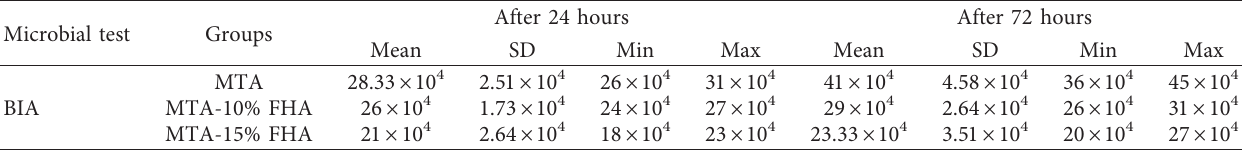
Table 2: The means and standard deviations of colony counts (CFU/mL) based on the BIA test in the study groups. Microbial test